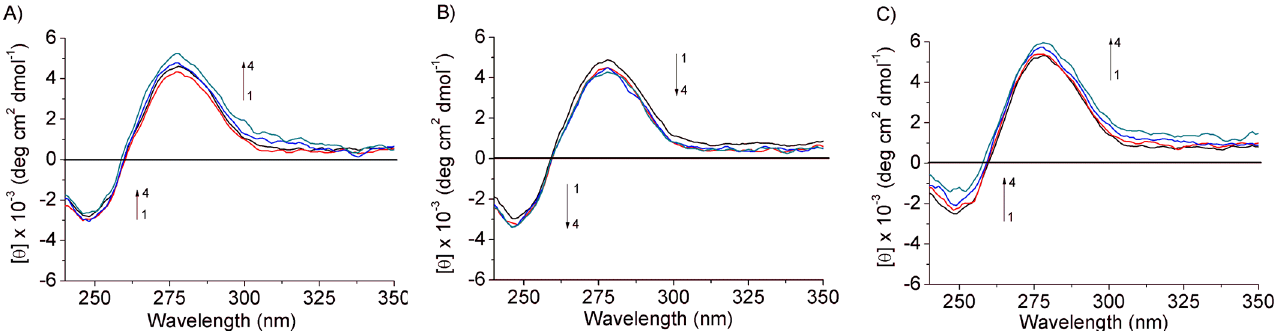
Fig 8. Effect of the isophorone derivatives on the DNA conformation. Circular dichroism (CD) spectra of DNA (30.9 μ M) treated with: A) 0.0 (black line), 12.82 (red line), 38.07 (blue line), 62.81(green line) μ M (curves 1 – 4) of Isoa, B) 0.0 (black line), 12.82 (red line), 38.07 (blue line), 62.81(green line) μ M (curves 1 – 4) of Isob, C) 0.0 (black line), 12.82 (red line), 38.07 (blue line), 62.81(green line) μ M (curves 1 – 4) of